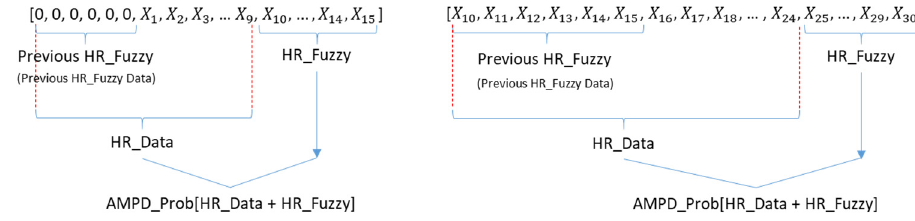
Figure 12. The first window ( left ); the second window with HR_Fuzzy = 6 ( right ).